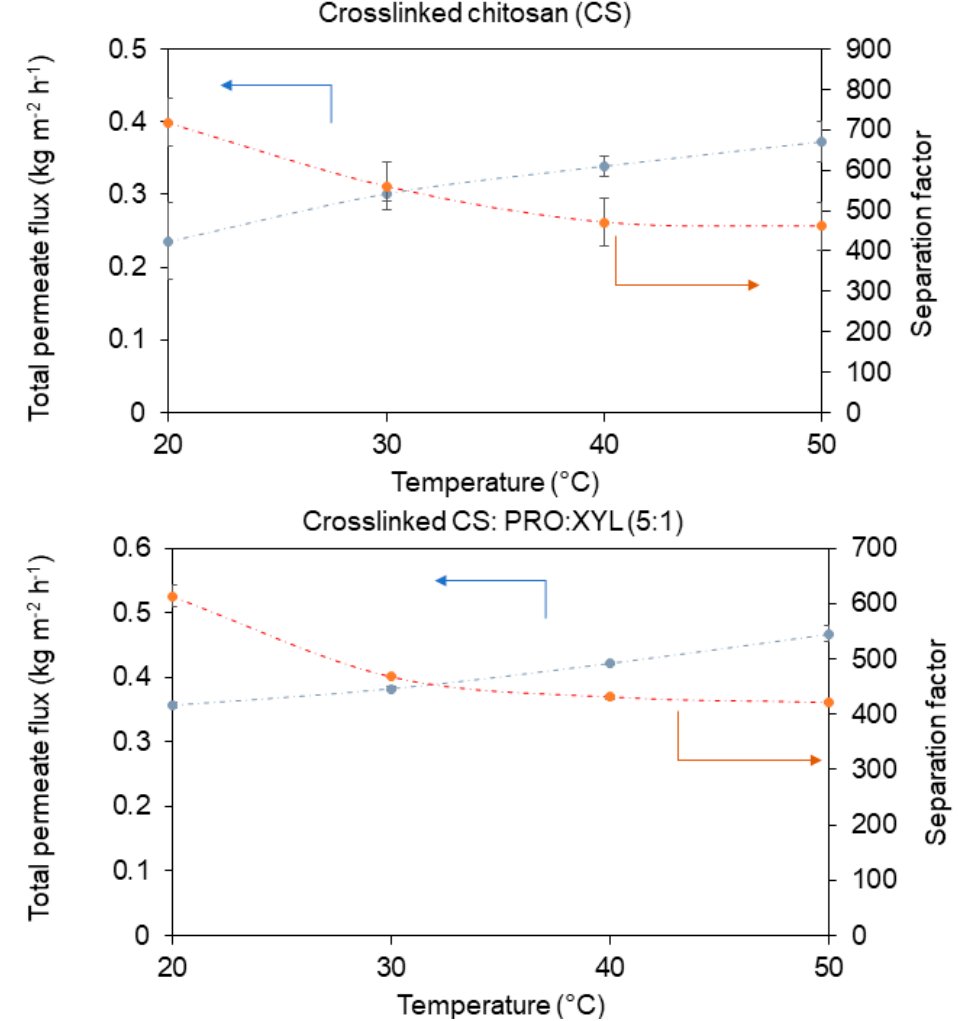
Figure 6. Permeation and separation factor as function of feed temperature (10:90 wt.% water:ethanol, pressure: 1 mbar). The curves are only guiding the eye.